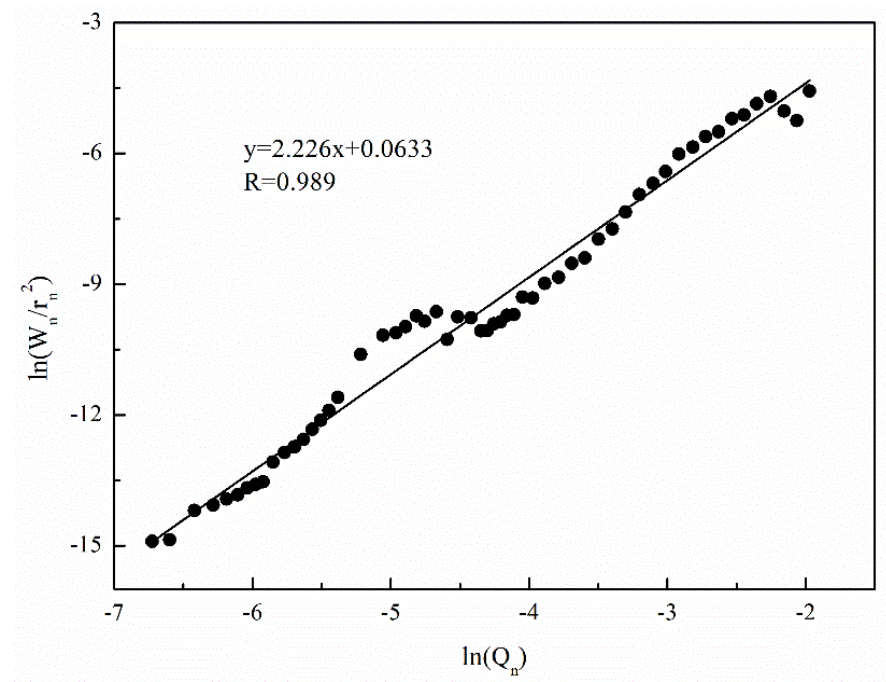
Figure 6. Fitting curves of the fractal dimension of the